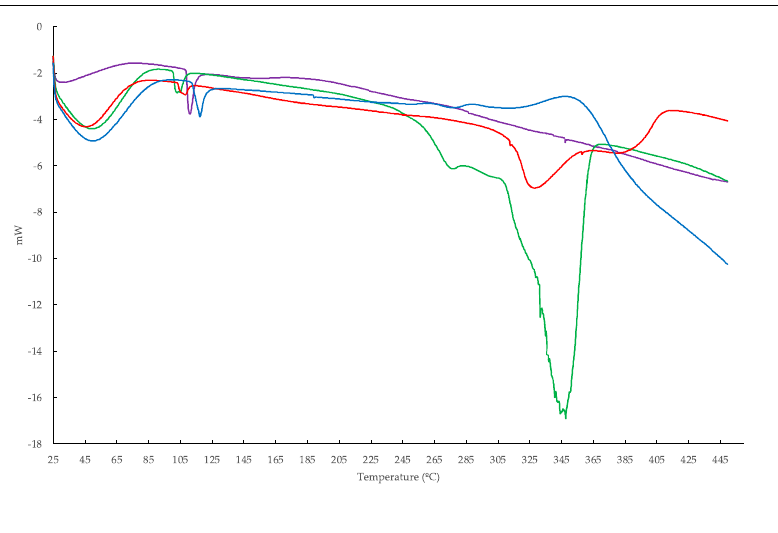
Figure 4. The differential scanning calorimetry (DSC) curves for the (green) β -cyclodextrin, (lilac) Fe 3 O 4 nanoparticles, (red) β -cyclodextrin-epichlorohydrin polymer, and (blue) β -CD-EPI polymer- modified Fe 3 O 4 nanoparticles.